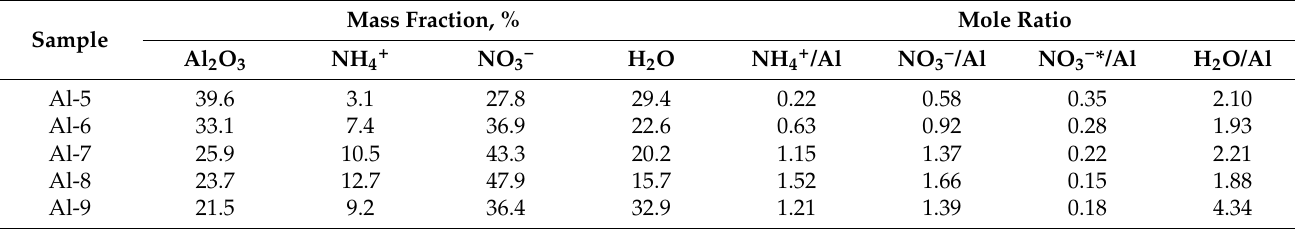
Table 2. Chemical composition of xerogels.